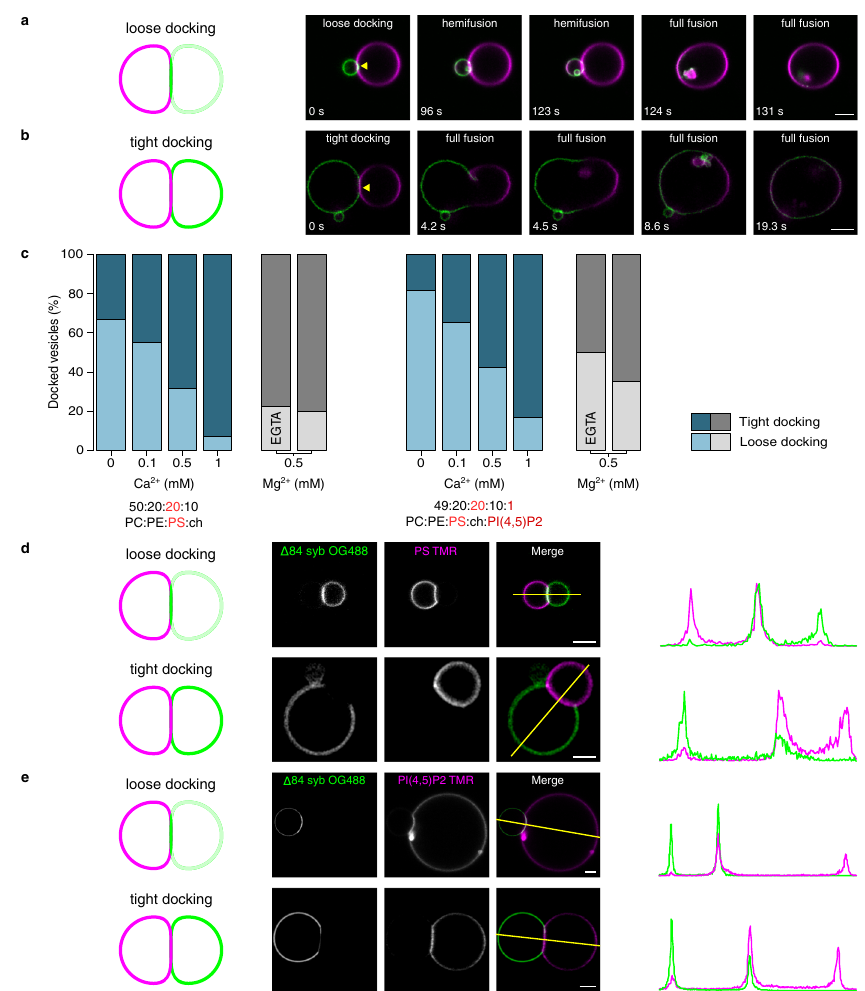
Fig. 2 Loose and tight docking states are fusion intermediates enhanced by, but not dependent on divalent cations. a, b Time series of GUVs docked in loose ( a ) or tight ( b ) way transiting to the fully fused state (rare cases). Membrane and protein labeling as in Fig. 1. c Occurrence frequency of loose and tight docking in various concentrations of either Ca 2 + or Mg 2 + and in the presence of membranes that contain various amounts of the negatively charged lipids PS and PI(4,5)P2. Total number of interfaces used (bars from left to right): 42, 20, 44, 28, 22, 20, 49, 49, 40, 30, 18, 17. d , e Examples (from 3 independent experiments) of loosely and tightly docked GUV pairs containing Δ 84 syb labeled with OG (green) and membranes containing TMR labeled PS ( d ) or PI(4,5)P2 ( e ) (purple). PS distribution remains unaffected in both docking types while there is an enrichment of PI(4,5)P2 at loose docking interfaces. Scale bars 5 μ m. Source data are provided as a Source Data fi